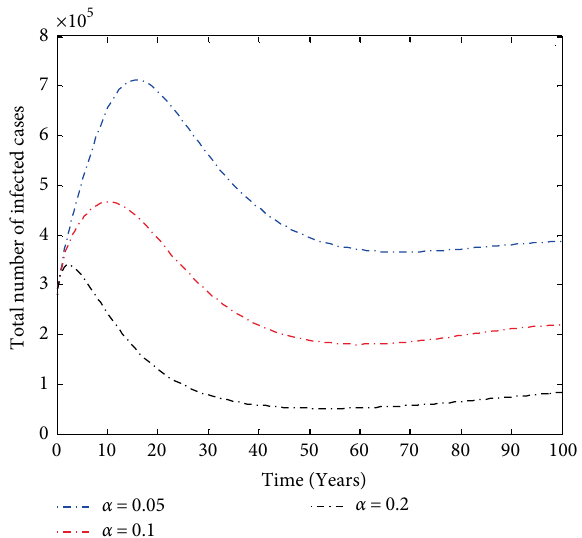
Figure 8: The effect of treatment coverage of high-risk latent class on the number of infected